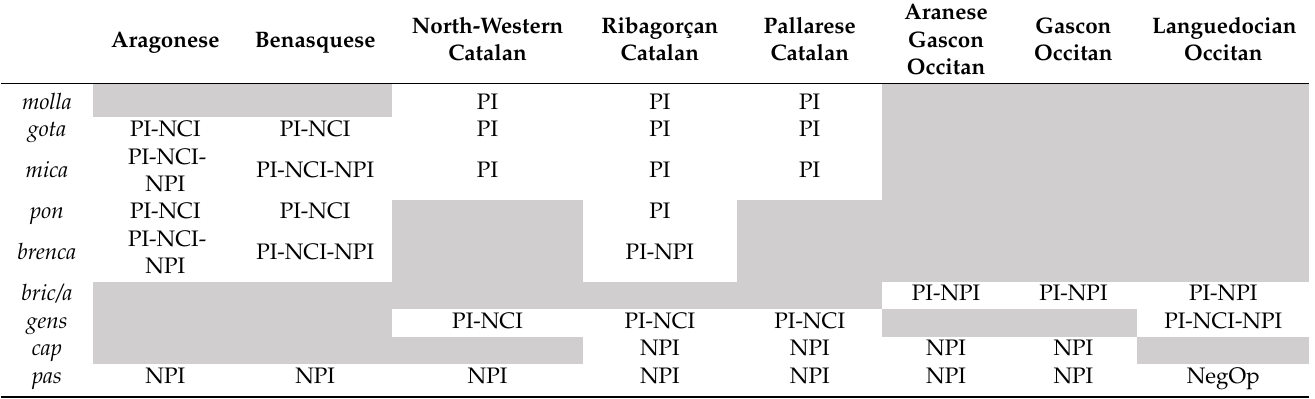
Table A3. The distribution and meaning of scalar minimizers in trans-Pyrenean Romance varieties 33 .